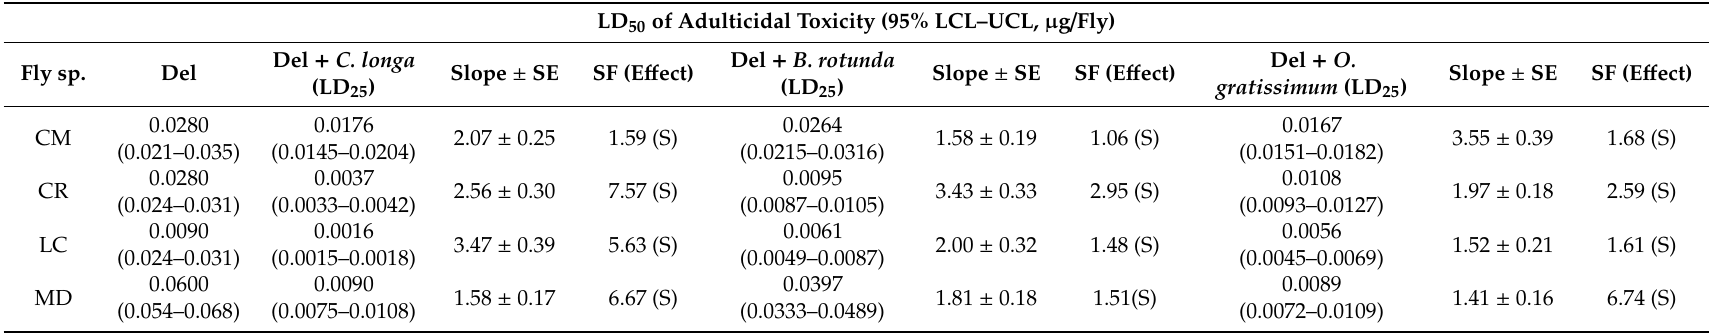
Table 8. Adulticidal toxicity of deltamethrin combined with three EOs against the blow flies and the house fly. LD 50 of Adulticidal Toxicity (95% LCL–UCL, µ g / Fly) Fly